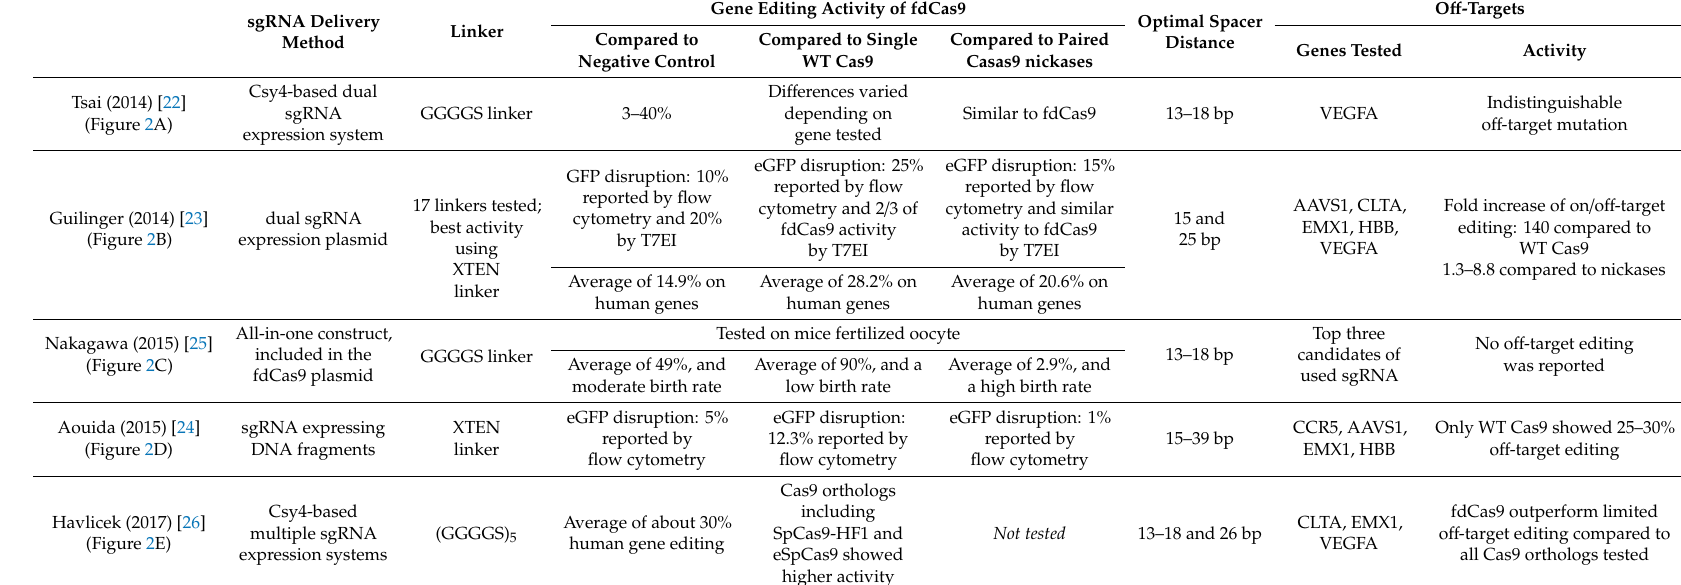
Table 3. Comparison between di ff erent fdCas9 constructs available in the